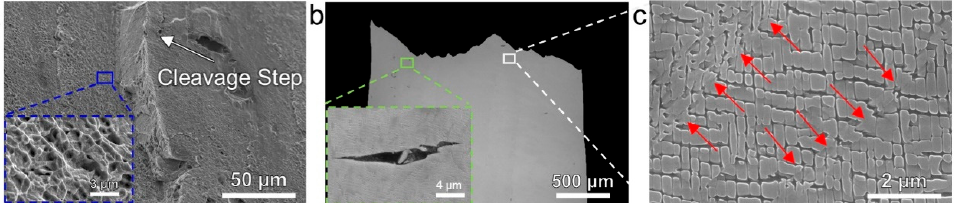
Figure 5. Fracture analysis after the tensile tests at RT. ( a ) Fracture surface of the sample showing the cleavage step (white arrow) and ductile dimples (blue rectangle). The loading direction is out of the plane. ( b ) Side view of the fractured sample. ( c ) Magnified image of the white rectangle in ( b ). The red arrows in ( c ) indicate the shear traces near the fracture surface. The tensile direction in ( b , c ) is vertical.